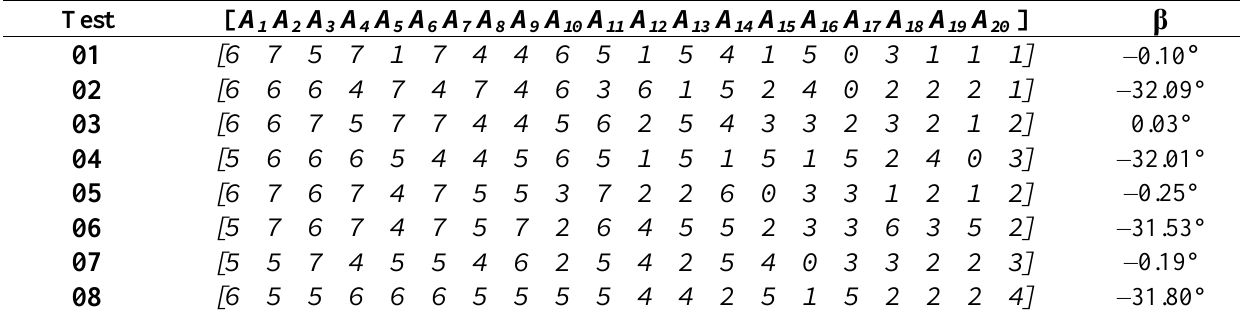
Table 5. Individuals with higher fitness in the second GA-MMC application test [13].